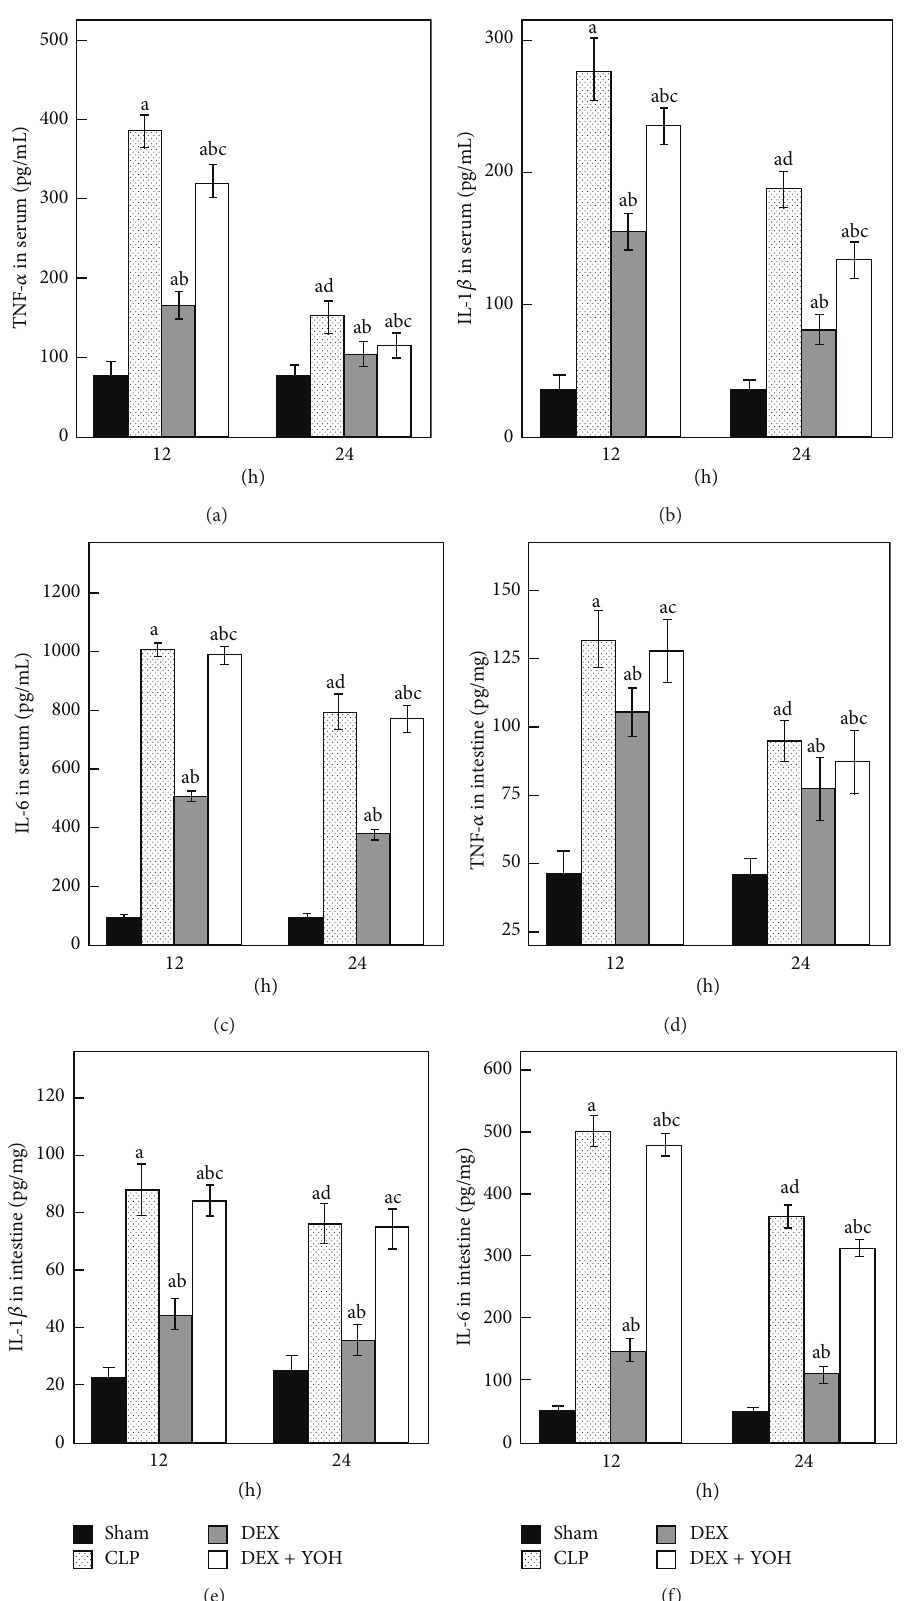
Figure 4: TNF- 𝛼 , IL-1 𝛽 , and IL-6 in experiment rats among four groups ( 𝑛 = 8 ). Data are expressed as mean ± SD. a 𝑃 < 0.05 , versus Sham group; b 𝑃 < 0.05 , versus CLP group; c 𝑃 < 0.05 , versus DEX group; d 𝑃 < 0.05 , versus CLP group 12